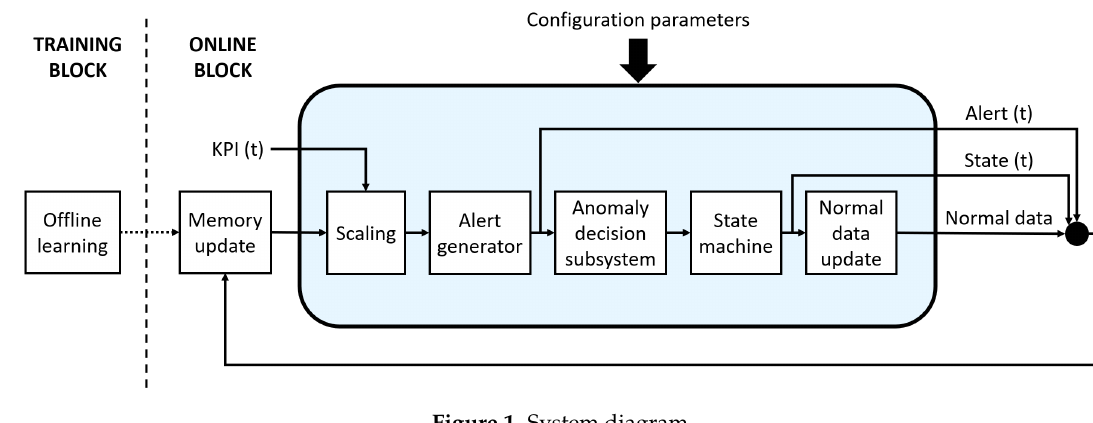
Figure 1. System